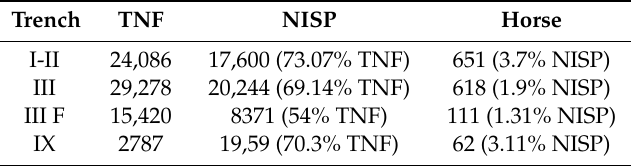
Table 1. The total number of bone fragments (TNF) with the number of identified specimens (NISP) and the frequency of species (horse skeletal remains) in the Ostr ó w Tumski